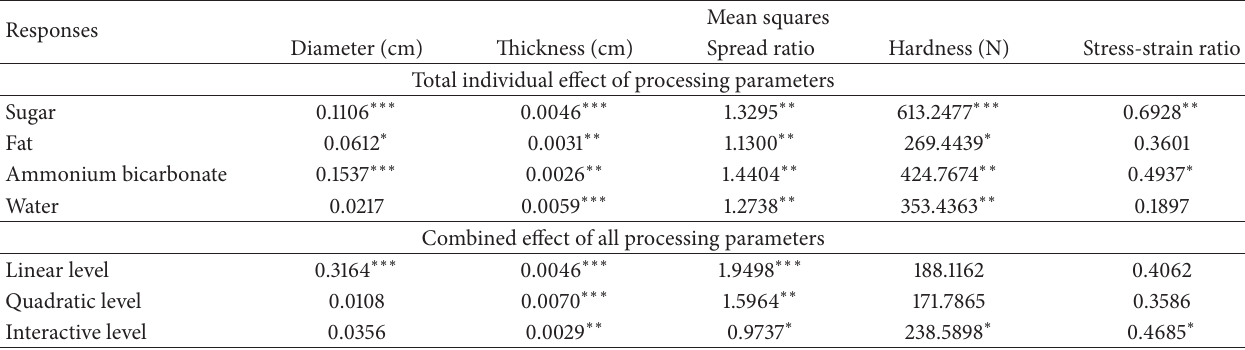
Figure 7: Surface plot representing the effect of fat ( 𝑋 2 ) and water ( 𝑋 4 ) on spread ratio of the biscuits. Table 2: ANOVA for the overall effect of processing parameters on the physical and textural responses a .